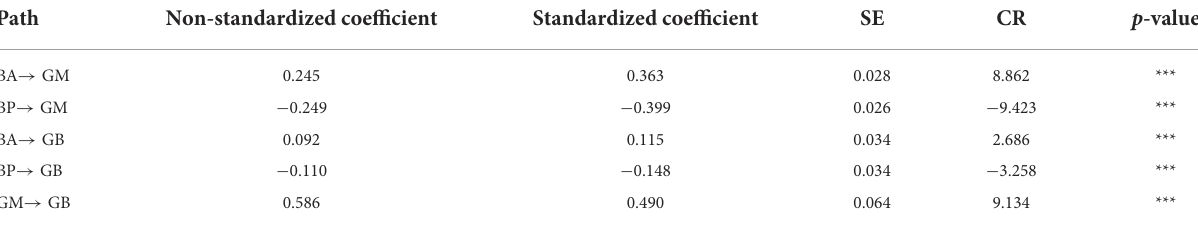
TABLE 8 Path inspection.